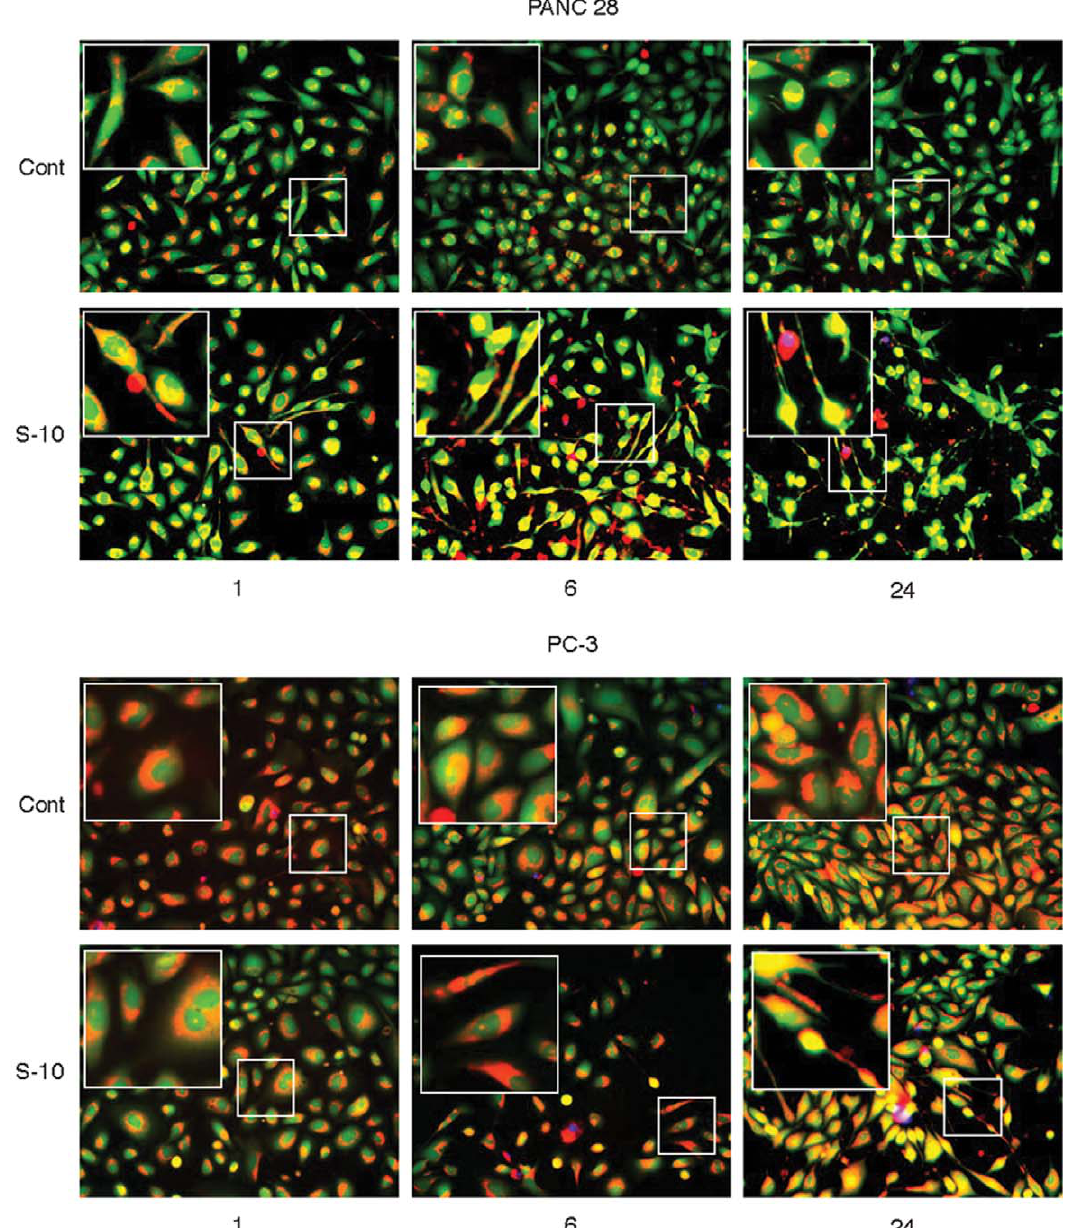
Figure 2. Simvastatin induced shape change and mitochondrial redistribution in cancer cells at early time points. PC-3 prostate cells and Panc 28 pancreatic cells were treated with 10 uM simvastatin and stained with calcein AM (green), MitoTracker CM-H2XRos, a reduced, non- fluorescent dye that fluoresces (red) upon oxidation, and DAPI, a staining dye that emits (blue) when bound to DNA. These images of PC-3 and Panc 28 were acquired via fluorescence microscopy and illustrate that changes in cell shape occurred within 6 hours becoming more extensive by 24 h. These shape changes were accompanied by a significant redistribution of mitochondria.